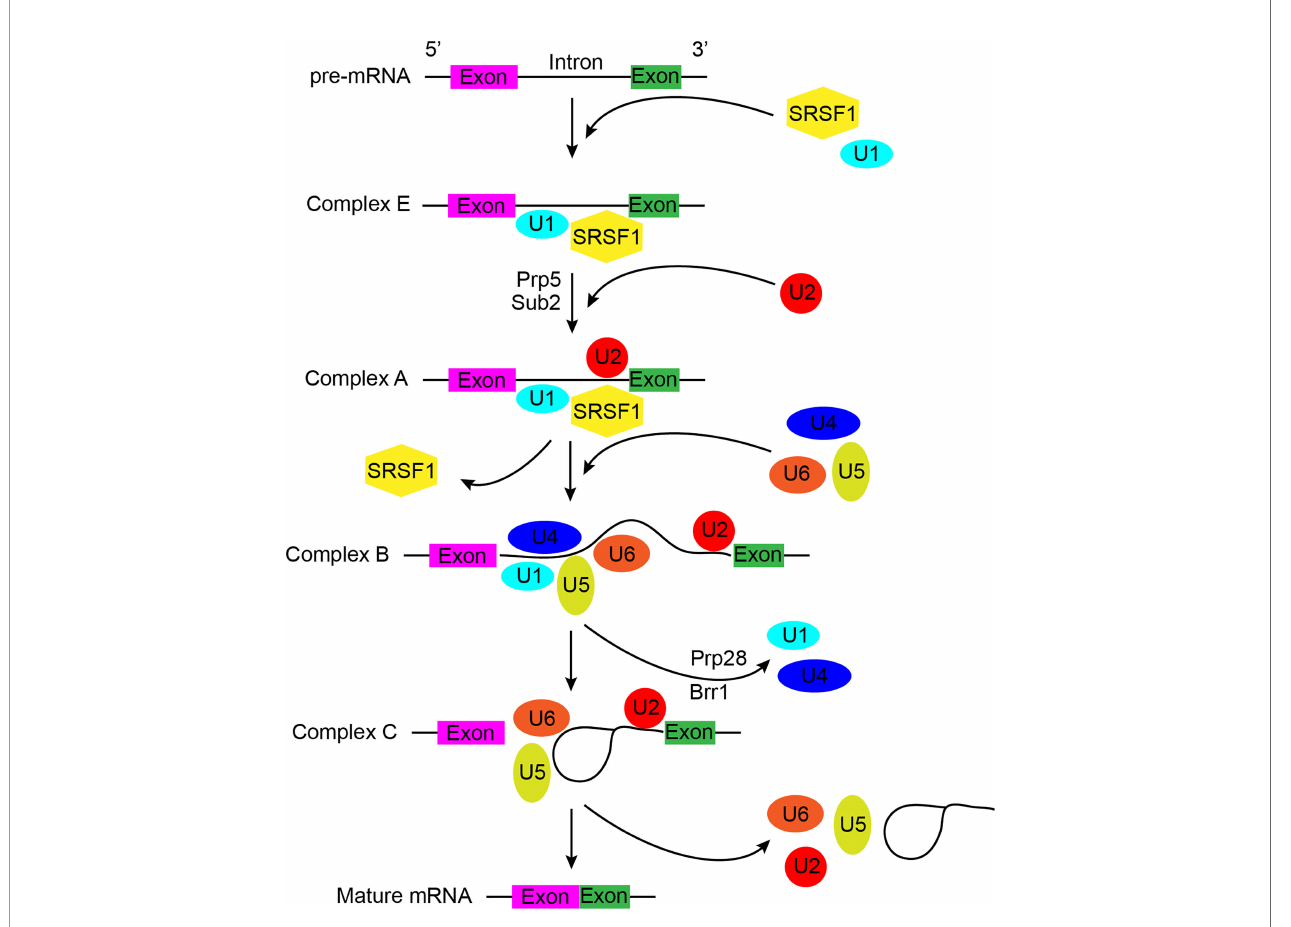
FIGURE 1 | A general schematic of pre-mRNA splicing by the major spliceosome, which describes the process in detail and indicates possible mechanisms underlying the potential function of spliceosome during splicing. Colored cuboids indicate exons, while the solid black lines represent